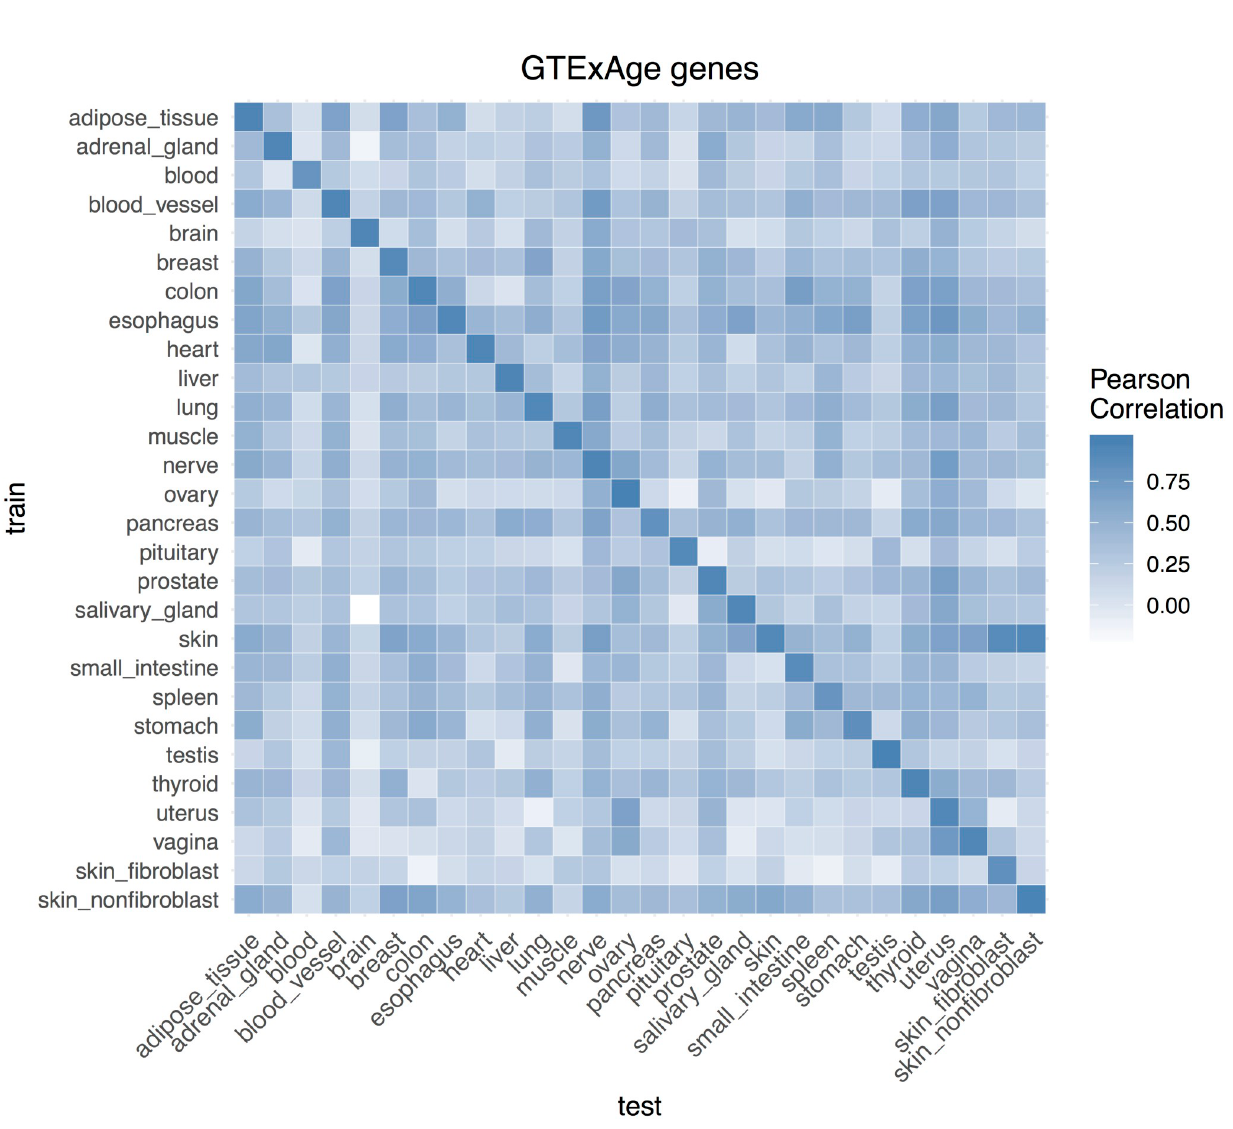
Fig 2. Heat-map of Pearson correlation matrix between predicted age and chronological age (based on GTExAge genes).